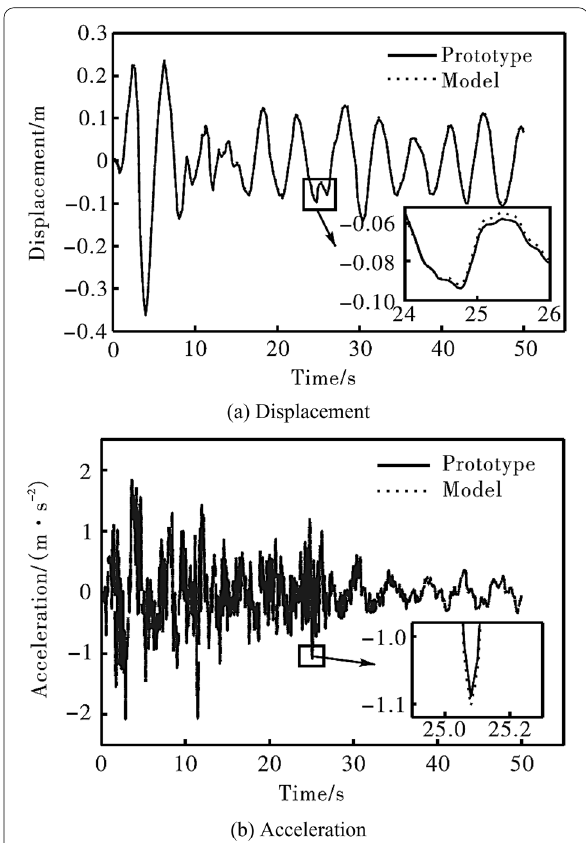
Fig. 5 Comparison of the pier top’s displacement and acceleration– time history response curves between the prototype and the